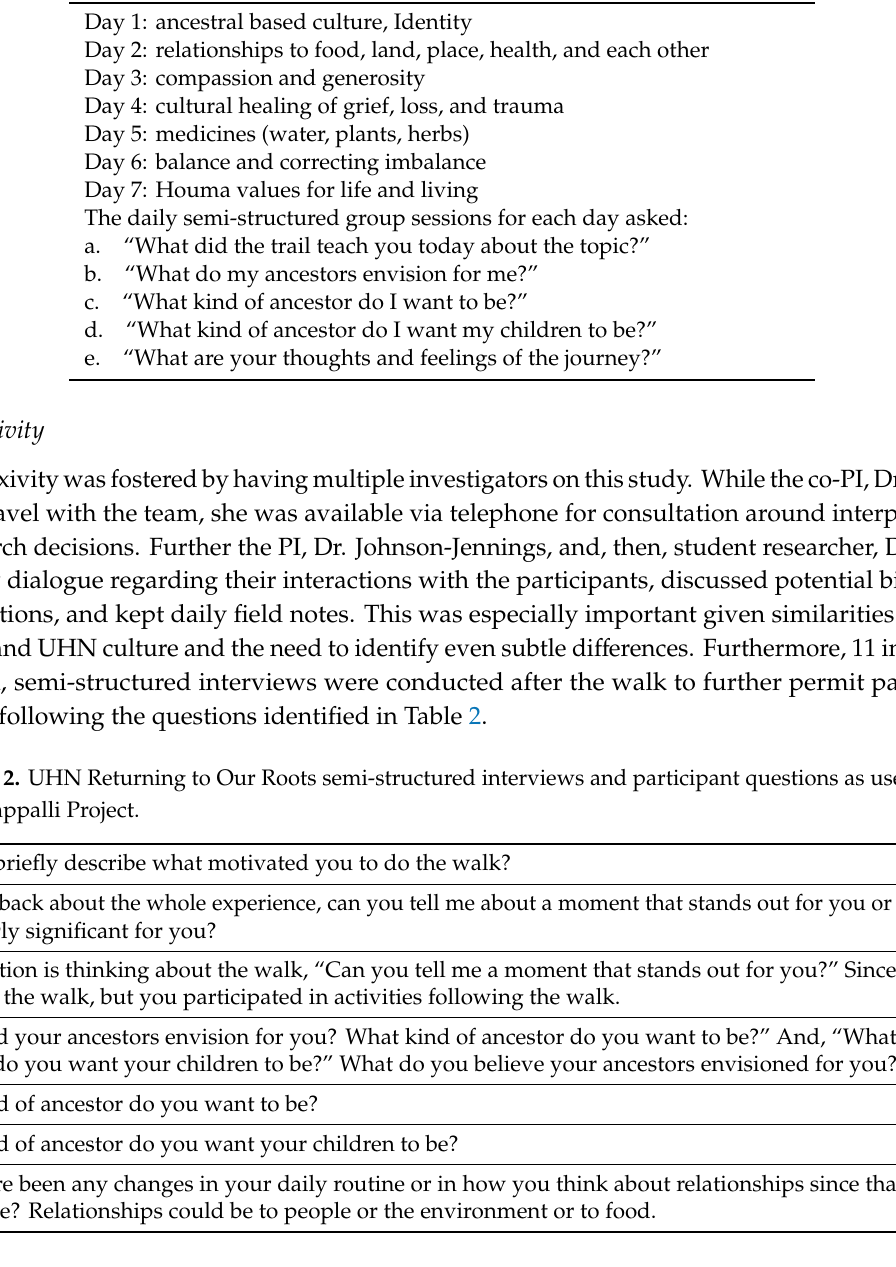
Table 1. United Houma Nation (UHN) Returning to Our Roots curricular themes and focus group questions as based on Yappalli.